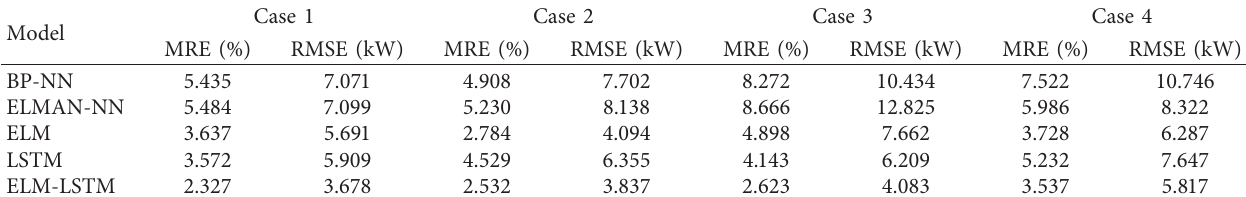
Table 1: Statistics of forecasting results errors of MRE and